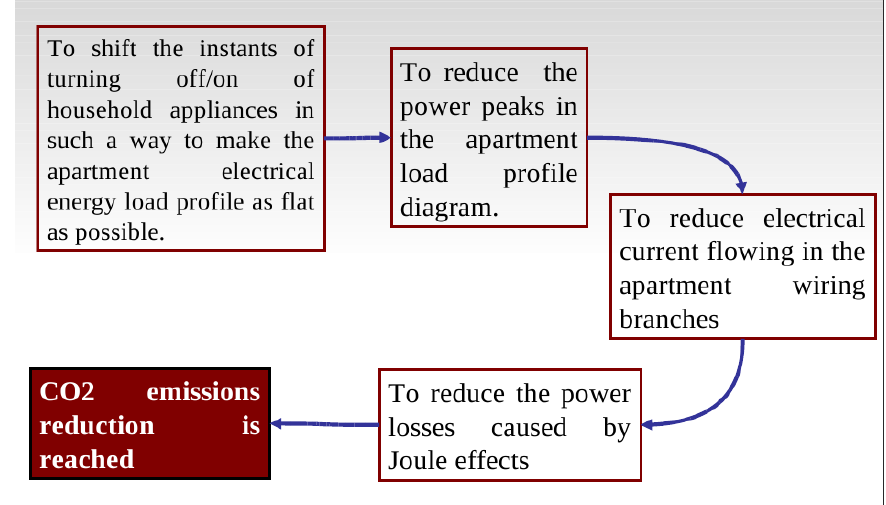
Figure 6. Load shifting action road